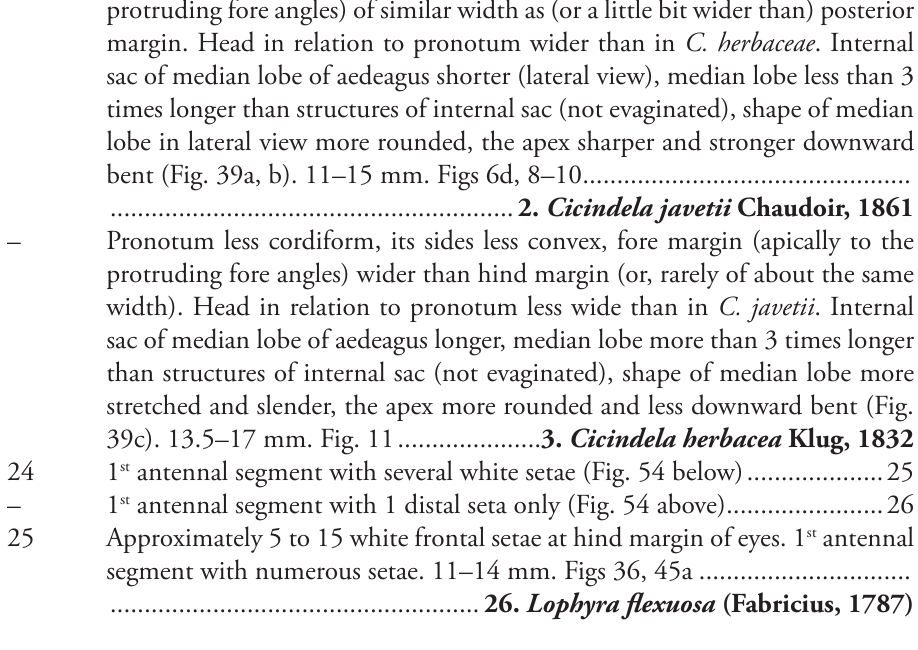
– Long metatibial spur shorter, about half of the length of 1 st metatarsal seg- ment (hind legs, Fig. 53). 4 teeth on inner side of left mandible (Fig. 51). In general, elytral pale spots more connected: the fore discal spot with an exten- sion to the neighboring marginal spot; the marginal spots connected to three pairs (humeral, medial, and apical lunules). Median lobe of aedeagus similar to that one of C. littoralis , but with apical part less bent ventrally (Fig. 41). Copulatory piece of median lobe of aedeagus straight or slightly curved, tip broadly rounded (Fig. 42 top). 9–13 mm. Fig. 20......................................... 20 Elytra green with pale pattern reduced to spots or small bands and small red- dish areas (Figs 8–11, 23).......................................................................... 21 – Elytral coloration different, not green, if so then pale patterns larger and complex ................................................................................................ 24 21 Labrum with 3 teeth on anterior margin (Fig. 6). Each elytron with 2 to 4 pale spots which are not connected ........................................................... 22 – Labrum with one tooth on anterior margin (Fig. 6). Each elytron with (4 to) 5 pale spots, the 2 apical spots usually connected at the external margin ... 23 22 Each elytron with 2 (to 3) pale spots. Frons without setae. 1 st antennal seg- ment with one erect distal seta. 9.2–13.5 mm. Fig. 23 .................................. – Each elytron with 4 pale spots. Frons with few setae. 1 st antennal segment with few setae. 14–18 mm. Figs 6g, 12 ......................................................... ........................................... 4. Cicindela asiatica Audouin & Brullé, 1839 23 Pronotum more cordiform, its sides more convex, fore margin (apically to the protruding fore angles) of similar width as (or a little bit wider than) posterior margin. Head in relation to pronotum wider than in C. herbaceae . Internal sac of median lobe of aedeagus shorter (lateral view), median lobe less than 3 times longer than structures of internal sac (not evaginated), shape of median lobe in lateral view more rounded, the apex sharper and stronger downward bent (Fig. 39a, b). 11–15 mm. Figs 6d, 8–10 ................................................ – Pronotum less cordiform, its sides less convex, fore margin (apically to the protruding fore angles) wider than hind margin (or, rarely of about the same width). Head in relation to pronotum less wide than in C. javetii . Internal sac of median lobe of aedeagus longer, median lobe more than 3 times longer than structures of internal sac (not evaginated), shape of median lobe more stretched and slender, the apex more rounded and less downward bent (Fig.